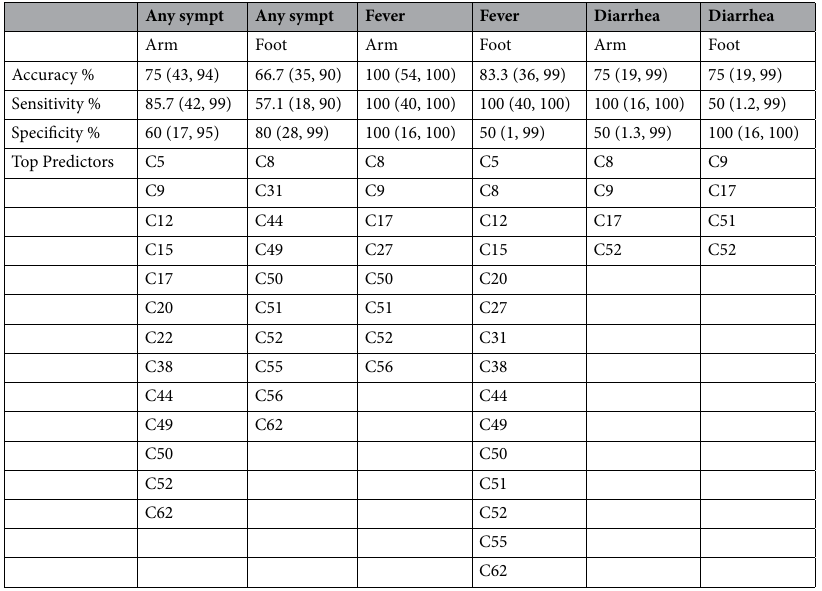
Table 1. Performance of trained models and 95% confidence intervals when used to predict symptomatic malaria infected (SM) vs. symptomatic uninfected (SU) children in the test set. SM with any symptom n = 29,